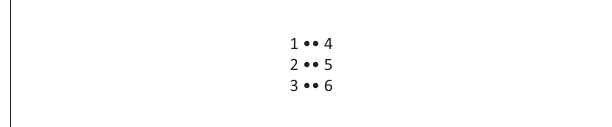
FIGURE 1: Braille cell with numbered